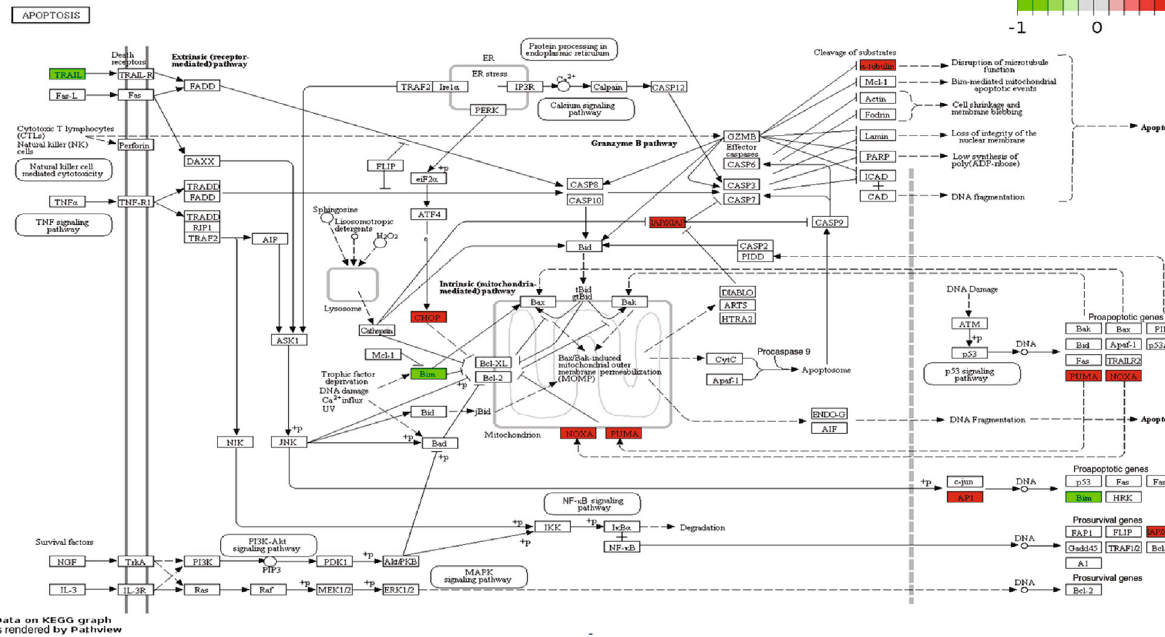
Figure 5: Apoptosis signaling pathway in Huh7 cells treated with FO. Expression changes of target genes are mapped by colors: red color marks increased genes; green color marks decreased